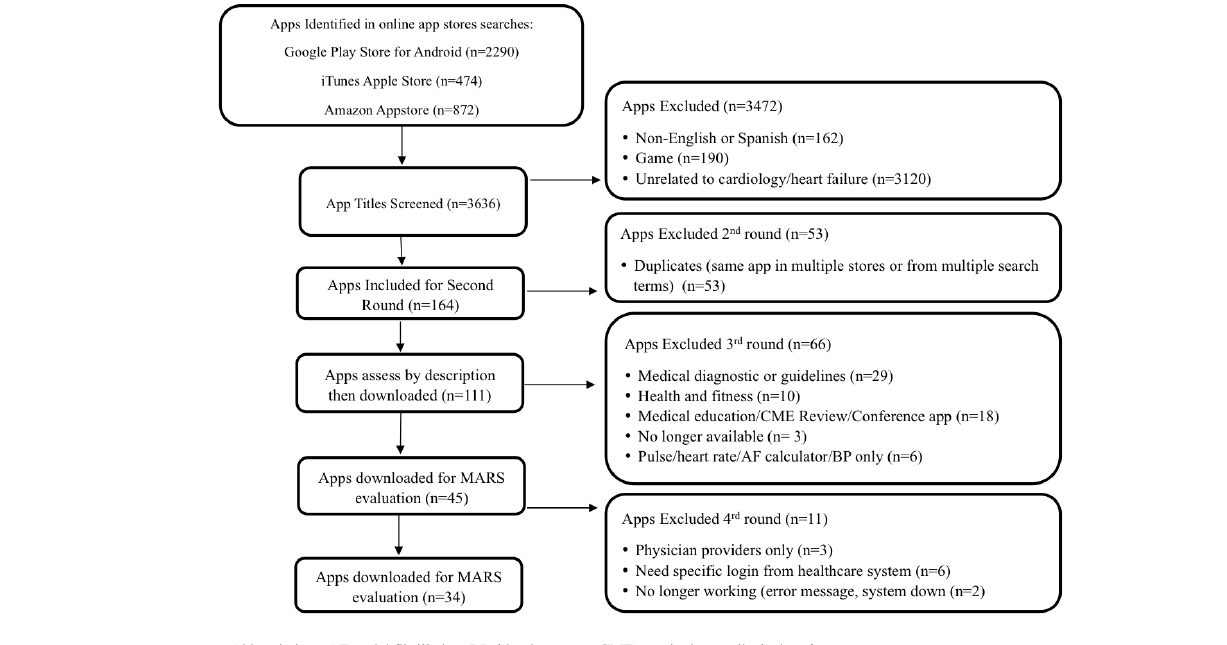
Figure 1. Screening process flowchart.